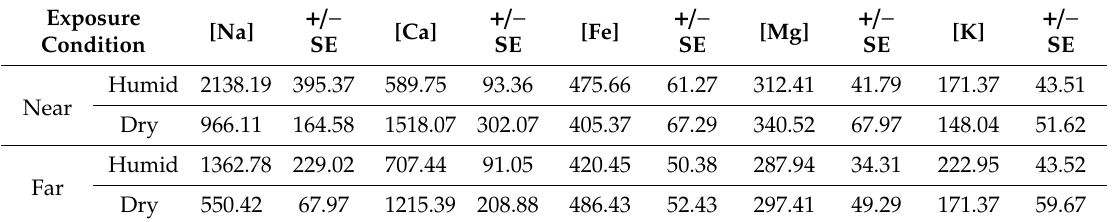
Table 1. Element content (mg kg − 1 ) in moss bags. Data reported as mean values +/ − standard error.